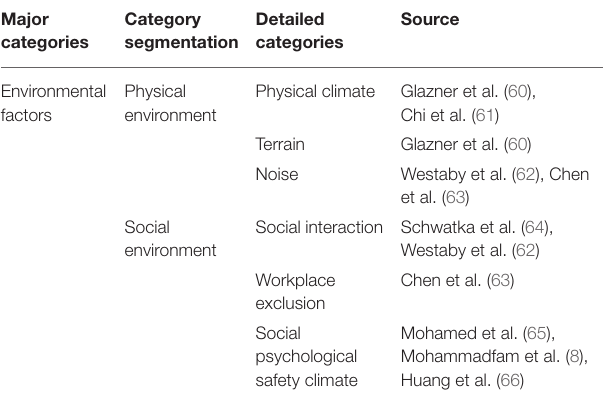
TABLE 3 | Individual factors.